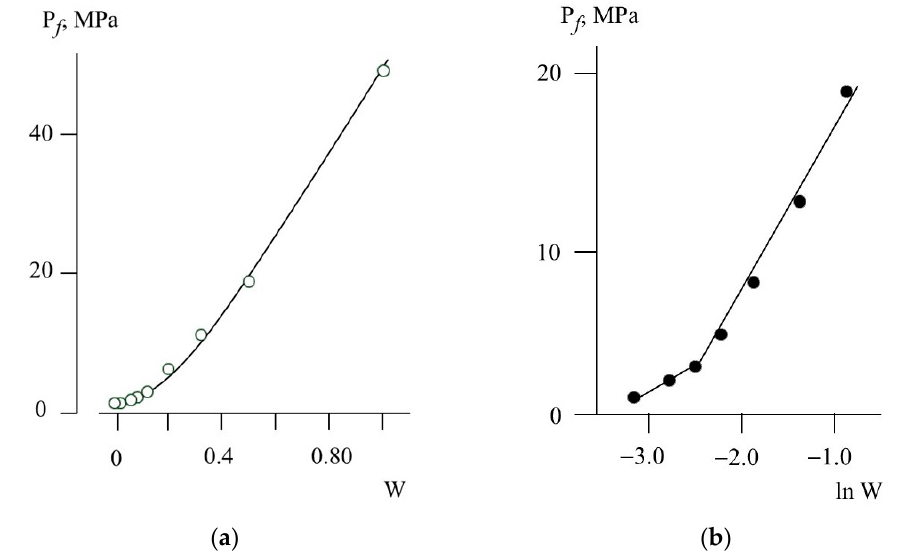
Figure 5. Dependence of the strength of polymer-sand crust P f on the weight fraction of PDADMAC in formulation W ( a ) and ln W ( b ).